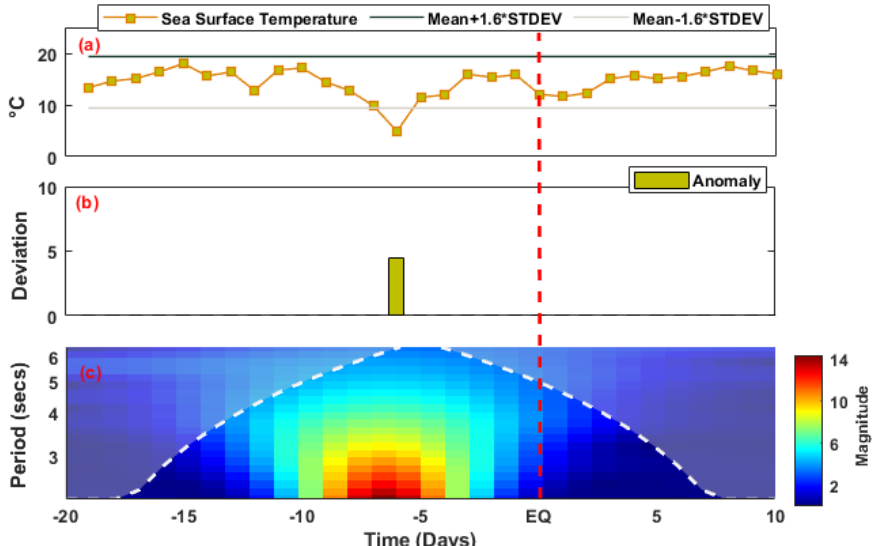
Figure 8. ( a ) The observation of SST data within the bounds, ( b ) SST data deviation from the bounds, ( c ) Continuous wavelet analysis of MODIS-SST time series data. The white dashed line marks cone of influence and red dashed line shows the earthquake day. The * is for multiplication.